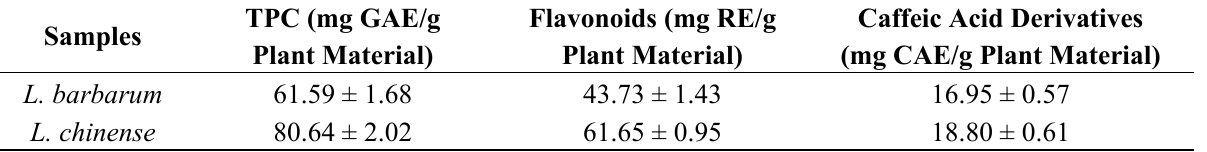
Table 2. The content of total polyphenols, flavonoids and caffeic acid derivatives in the